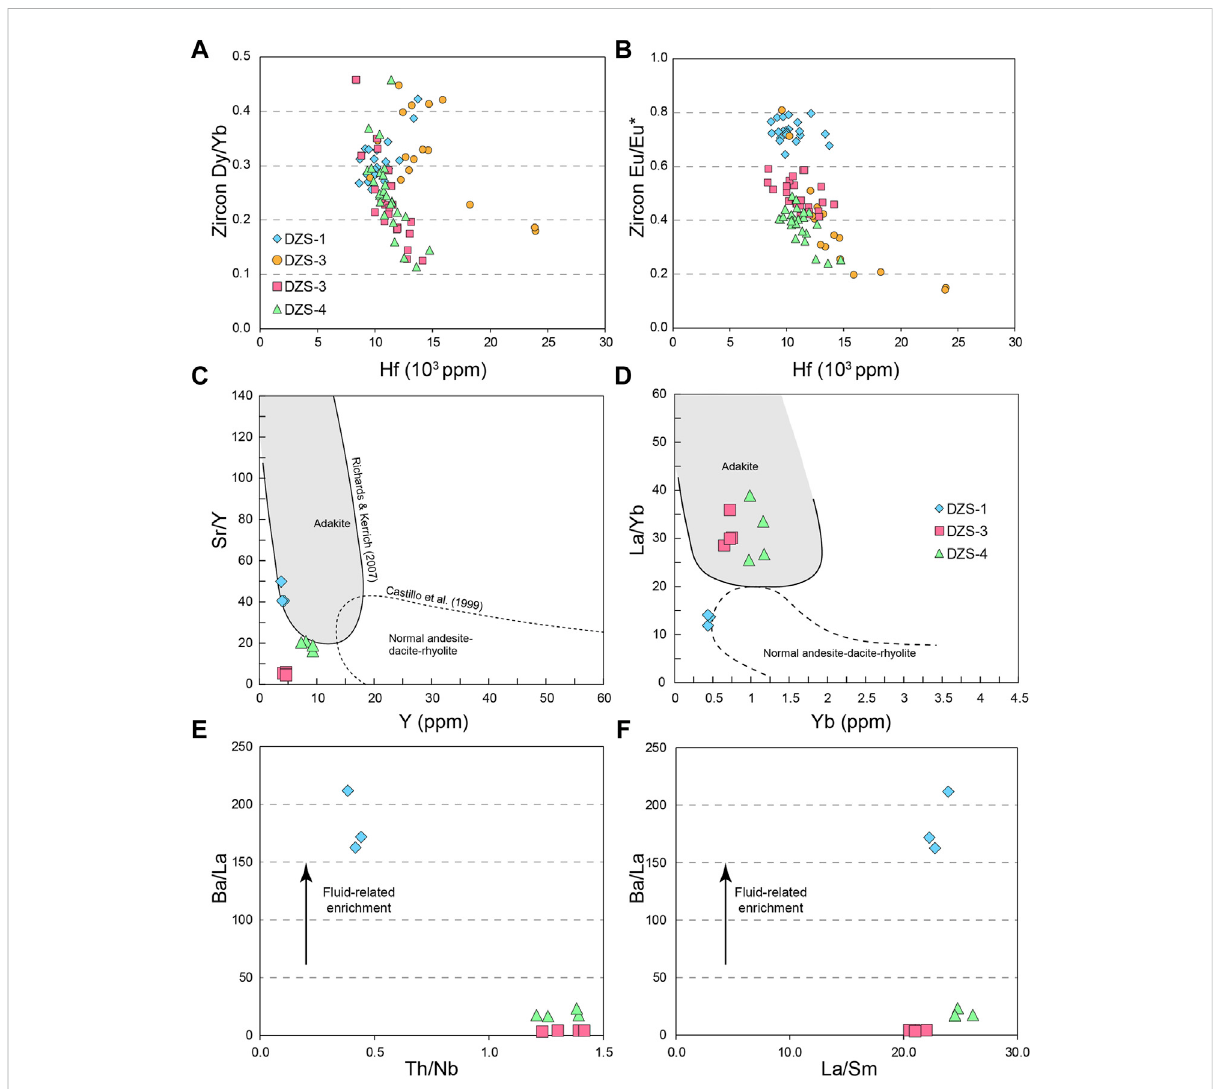
FIGURE 11 Zircon Dy/Yb (A) and Eu/Eu* (B) vs. Hf contents for the studied magmatic rocks. (C) Sy/Y vs. Y plot. The adakite and normal andesite-dacite- rhyolite fi eldsarefromRichardsandKerrich(2007)andCastilloetal.(1999),respectively. (D) La/Ybvs.Ybplot.Ba/Lavs.Th/Nb (E) andLa/Sm (F) plots. See the text for